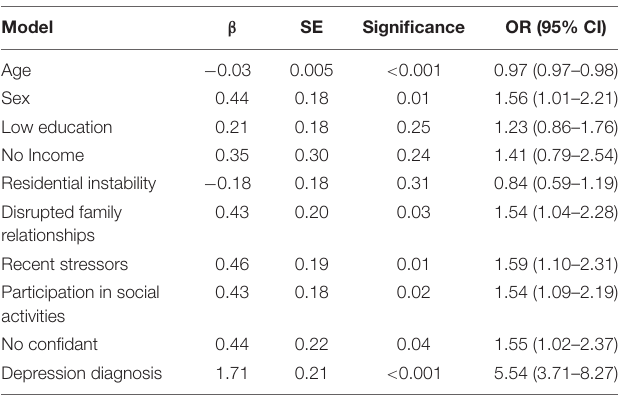
TABLE 2 | Combined suicide risk model (logistic regression).